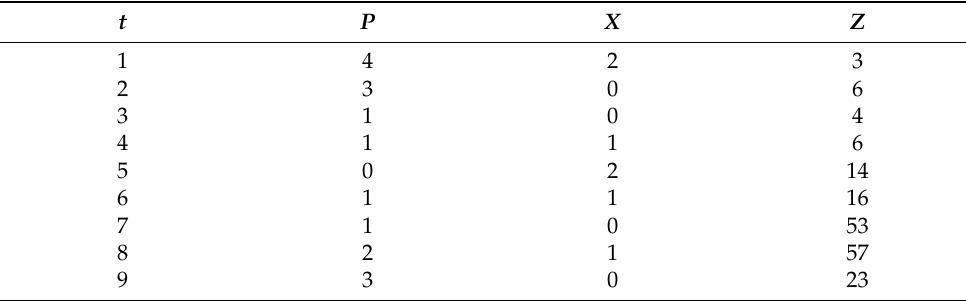
Table 1. Fragment of the initial data.